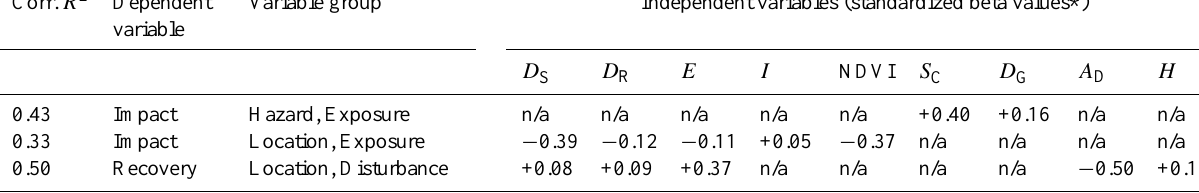
Table 9. Results of the regression analysis represented for the mangrove ecosystem. Corr. R 2